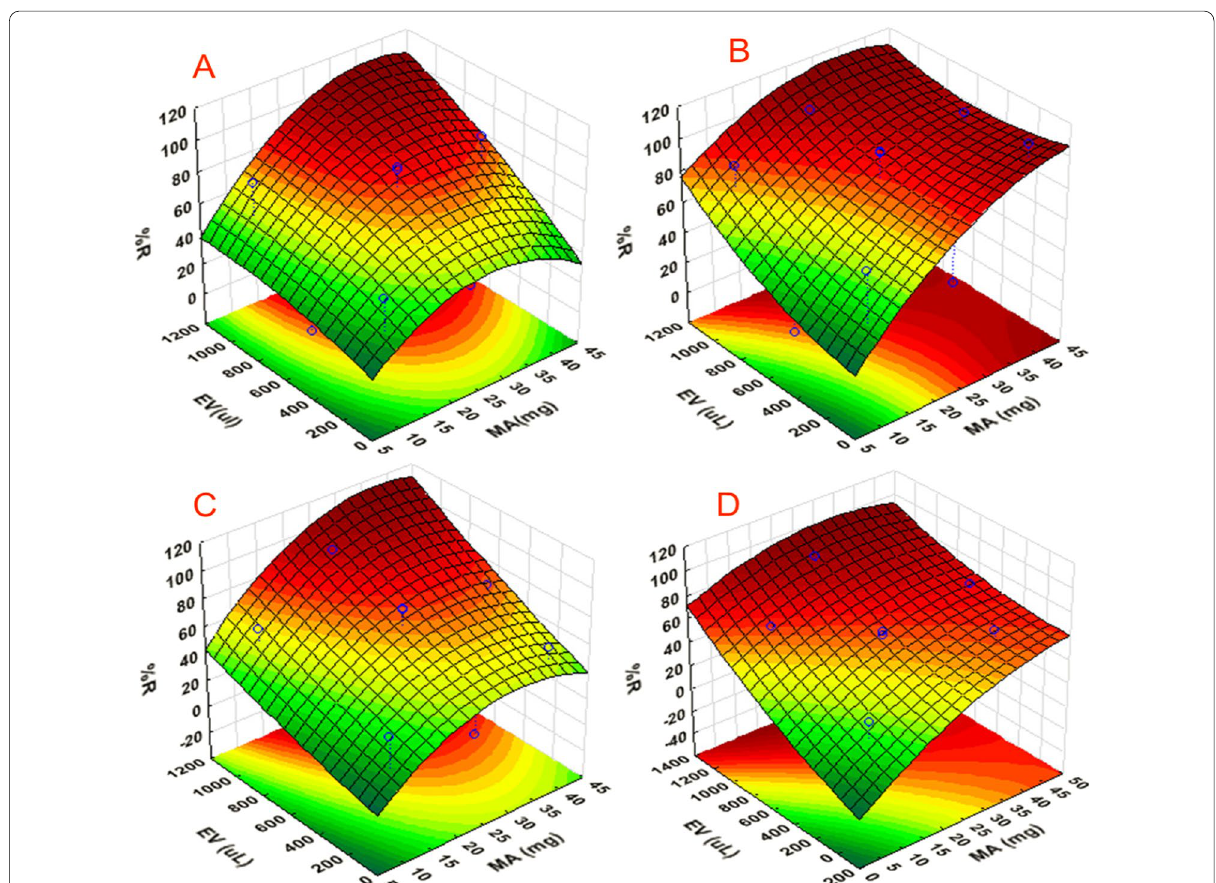
Fig. 7 Three-dimensional contour plots of a acetamiprid (ACT), b imidacloprid (IMD), c thiacloprid (TCL) and d clothianidin (CLD) describing the combined interactive effects of investigated factors ( EV eluent volume, MA mass of adsorbent) on the analytical